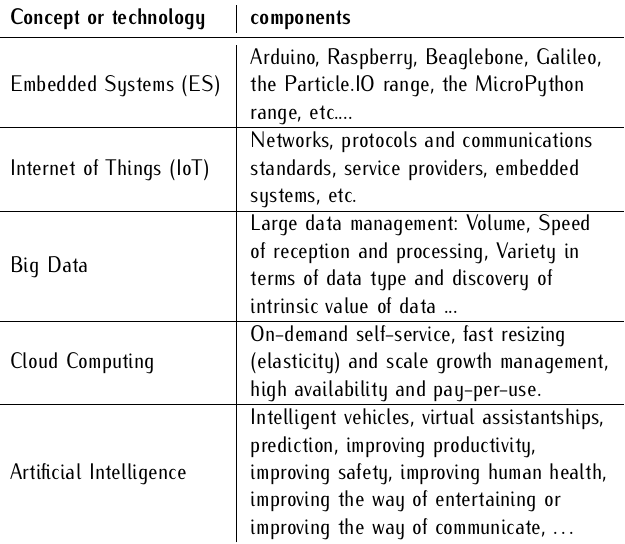
Table 2. Summary of the Technology Framework for Smart and